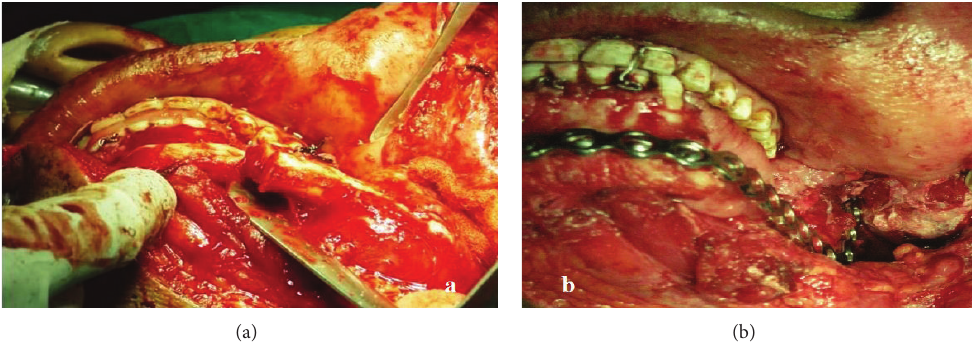
Figure 4: (a) Surgical photograph showing hemimandibulectomy and (b) condylar reconstruction